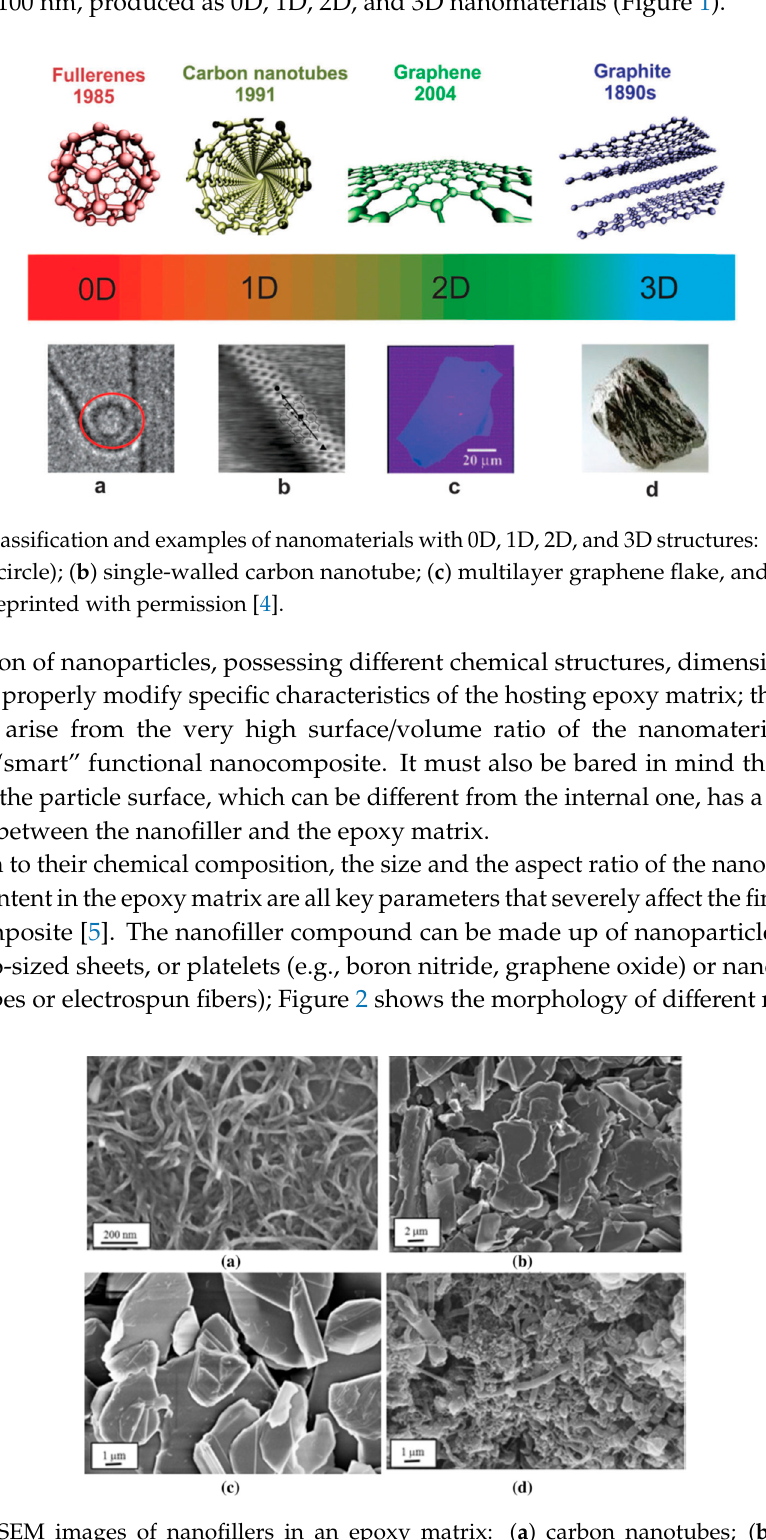
Figure 2. SEM images of nanofillers in an epoxy matrix: ( a ) carbon nanotubes; ( b ) graphene nanoplatelets; ( c ) boron nitride nanosheets; and ( d ) boron nitride nanotubes. Reprinted with permission [6].